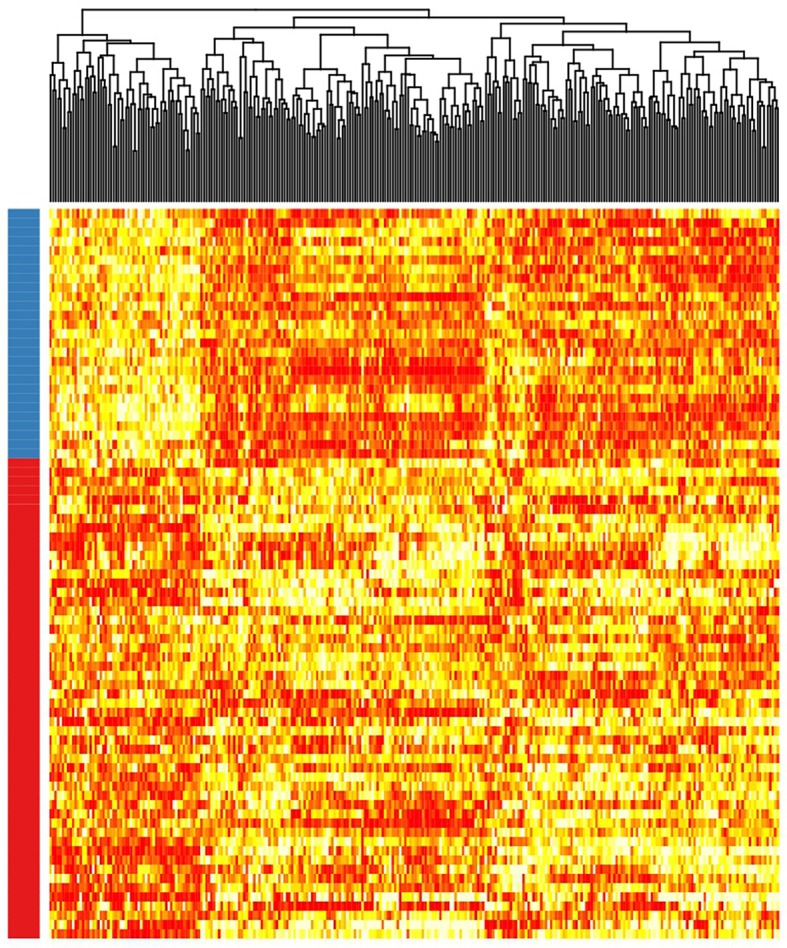
Heatmap showing the rank-transformed distribution of expression values for the 290 genes in the validation cohort. Red-labeled samples on the left bar petain to C1 and blue-labeled samples pertain to C2.